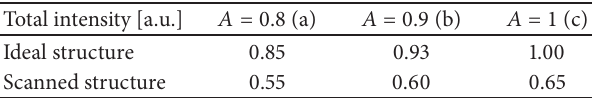
Table 3: Collected light according to value of the integral over the whole